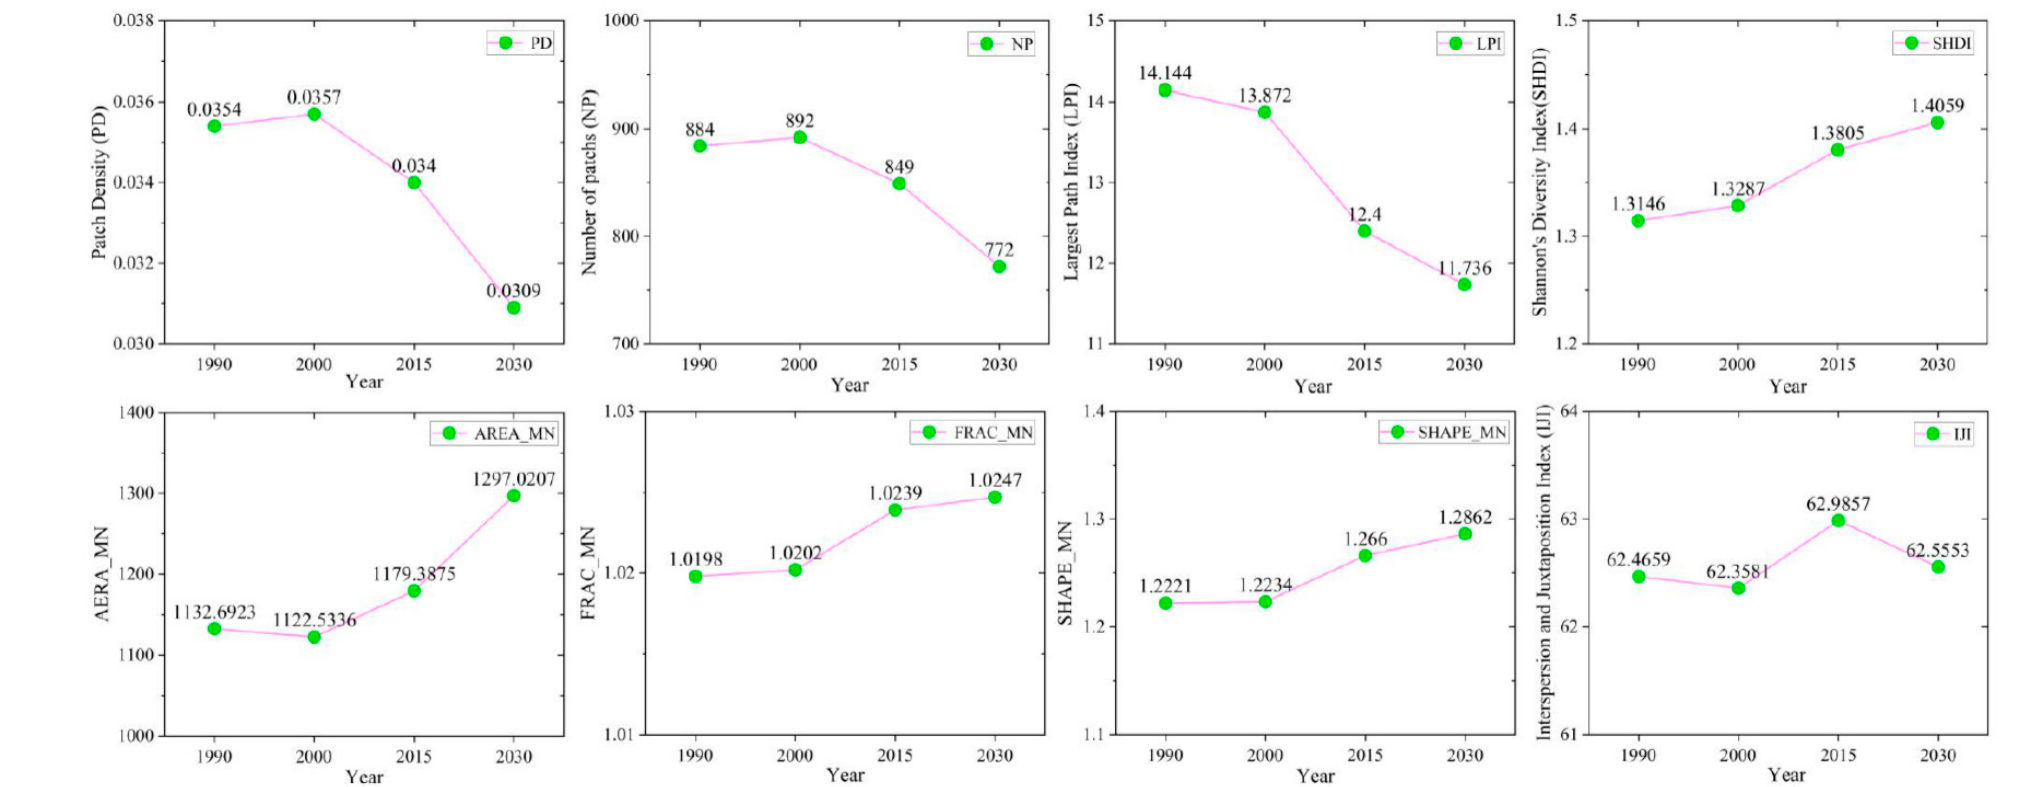
Figure 11. Changes in the land use pattern characteristics at the landscape level in Xi’an.